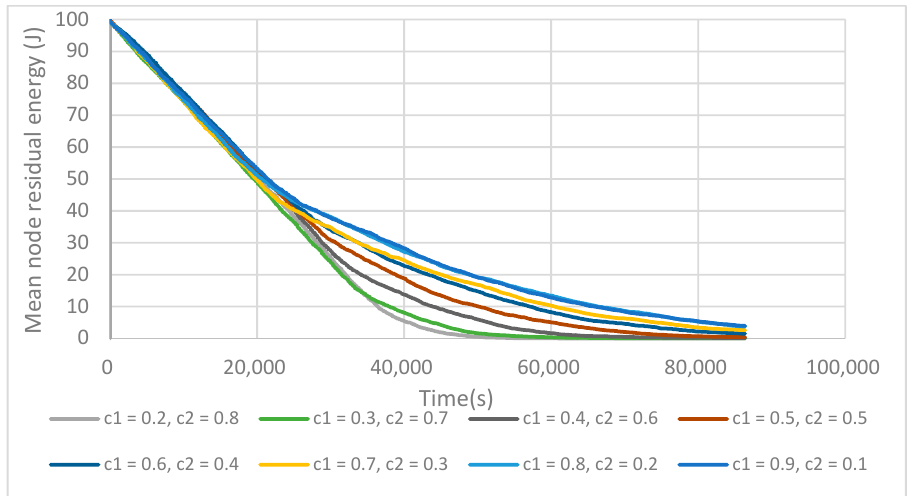
Figure 7. C1 and C2 value influences on the mean residual energy of the network. Well-positioned fCHs enables one to prolong the network lifetime.